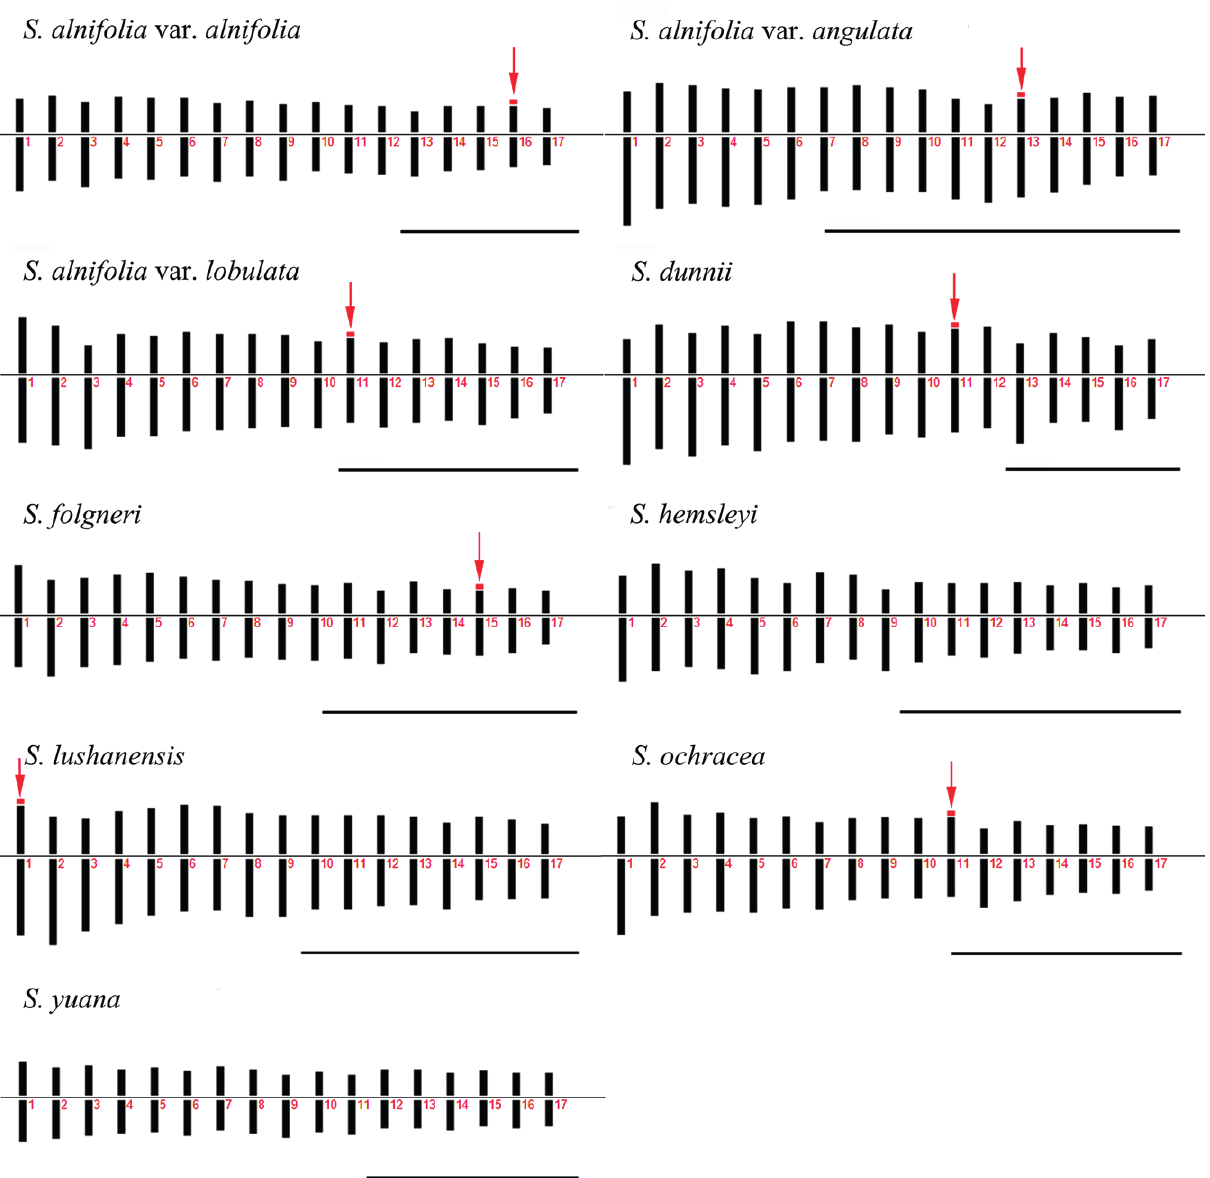
Figure 2. Haploid idiograms of Sorbus taxa. Red arrows indicate satellites. Scale bar = 5